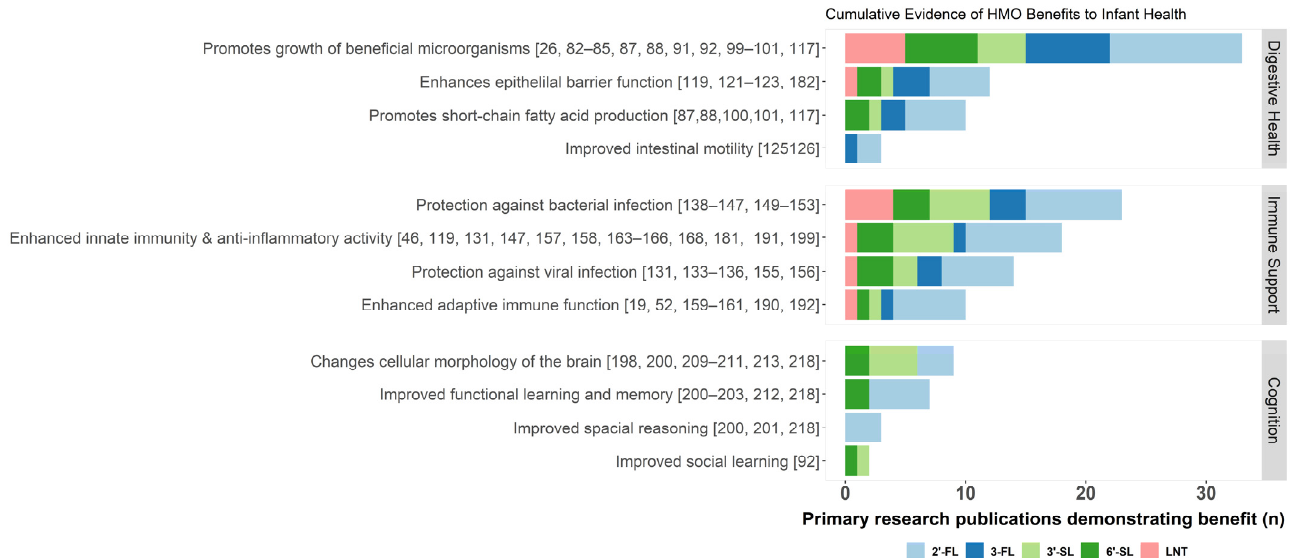
Figure 2. Summary of known benefits of acetylated (red), fucosylated (blue), and sialylated (green) HMOs. The cumulative evidence for each potential benefit is approximated by the number of independent primary research publications demonstrating evidence of an association between a given HMO and health benefit, indicated here by a stacked bar chart colored by HMO structure. HMO, human milk oligosaccharides; 2 ′ -FL, 2 ′ -fucosyllactose; 3-FL, 3-fucosyllactose; 3 ′ -SL, 3 ′ -sialyllactose; 6 ′ -SL, 6 ′ -sialyllactose; and LNT, lacto-N-tetraose.